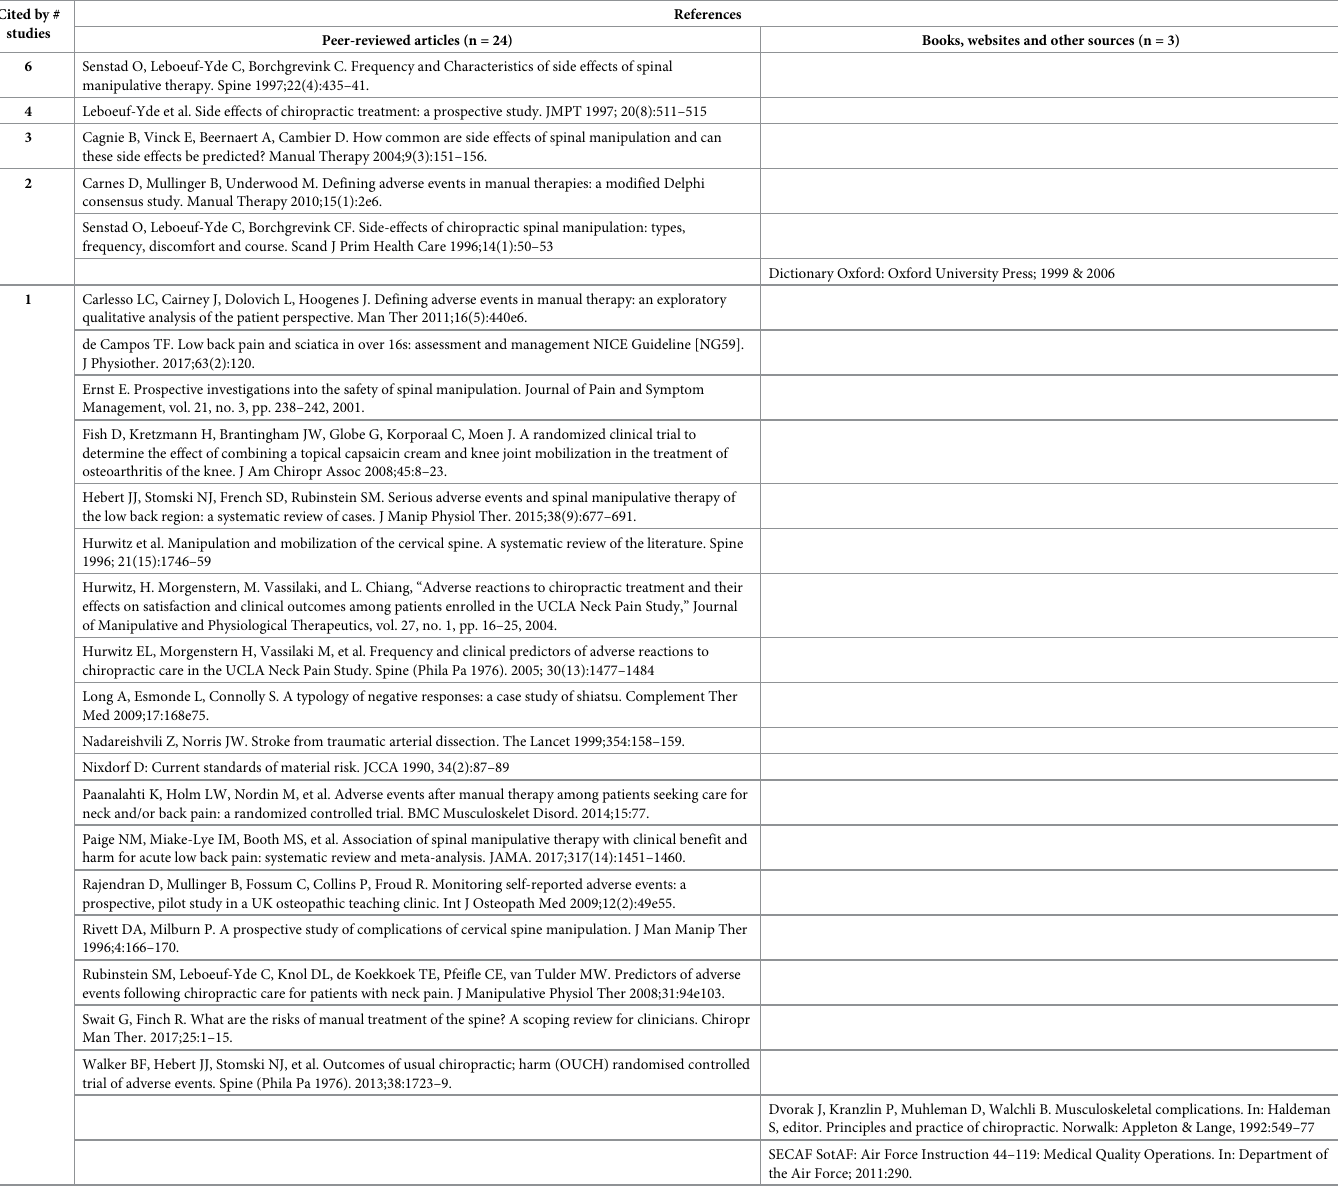
Table 9. References cited by studies providing an indirect adverse event definition and/or classification system (n = 27). Citedby#